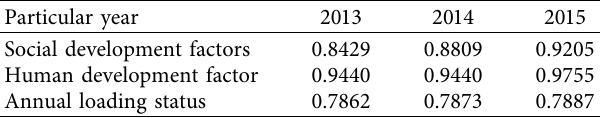
Table 5: Ecocultural bearing status of the social subsystem of London urban agglomeration.